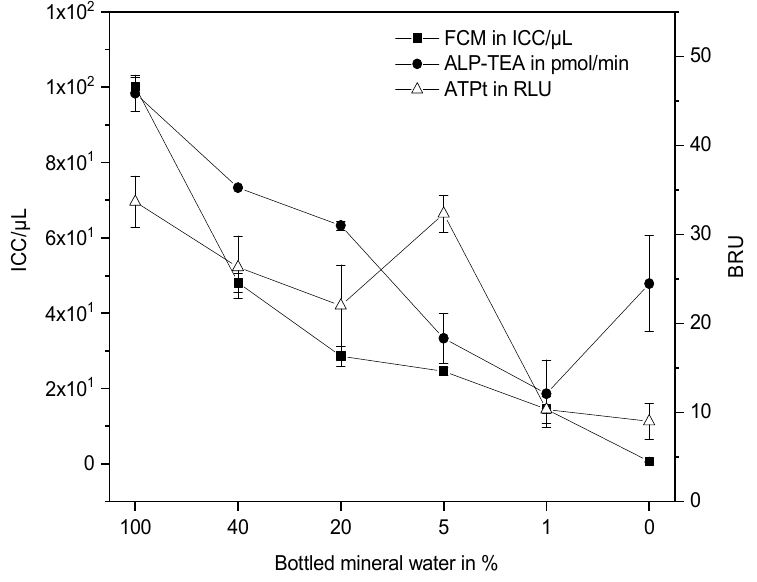
Figure 2. Correlation of FCM (n = 5), total adenosine triphosphate (ATPt, n = 3) and alkaline phosphatase-total enzymatic activity (ALP-TEA, n = 3) for measuring total biomass related units (BRU), samples from bottled mineral water (Evian) were diluted with ultrapure water from the same bottle, based on a method described in [13]. FCM samples were stained with SYBER ® Green and propidiumiodide, error bars indicate standard deviation on samples. Table 2. correlation coefficients of FCM, ALP-TEA and ATP methods.